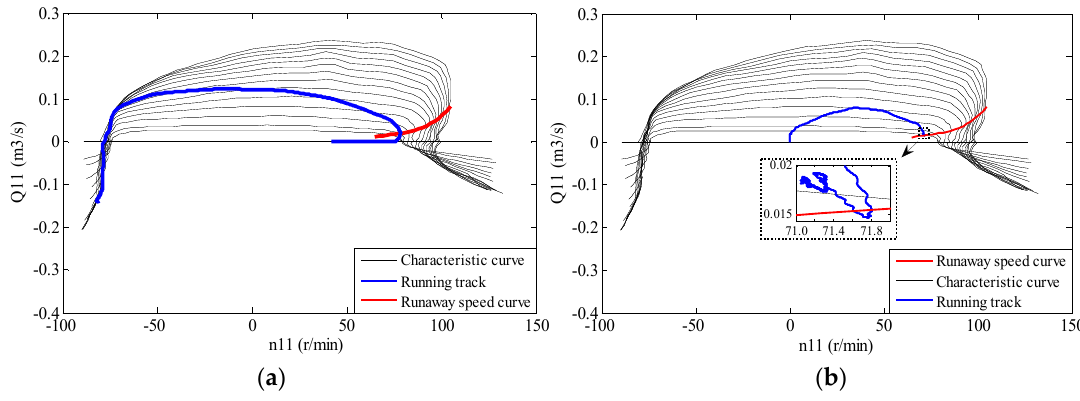
Figure 14. Running track of PSU in full characteristic curve: ( a ) pump outage conditions; ( b ) no-load start-up conditions.